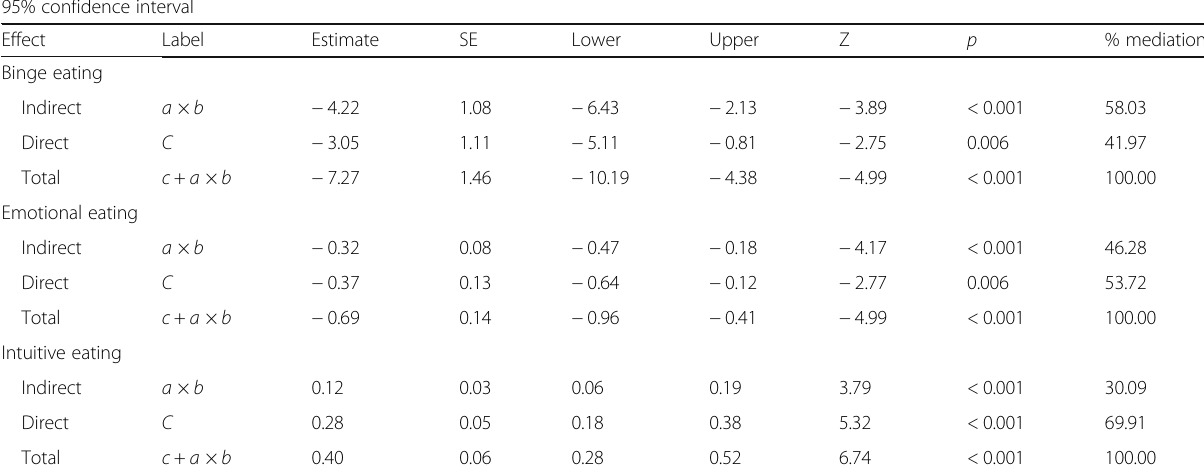
Table 5 Mediation estimates with 95% bootstrap confidence interval 95% confidence